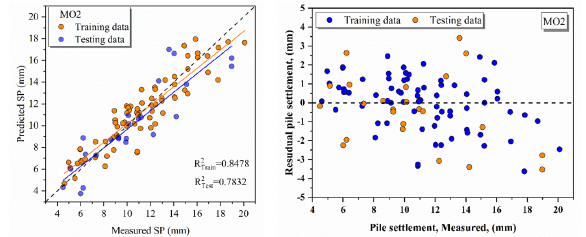
Fig. 6. Comparison between measured and predicted the pile settlement using MO2 for training and testing data (a) model prediction, and (b) residual pile settlement Eq. (12)